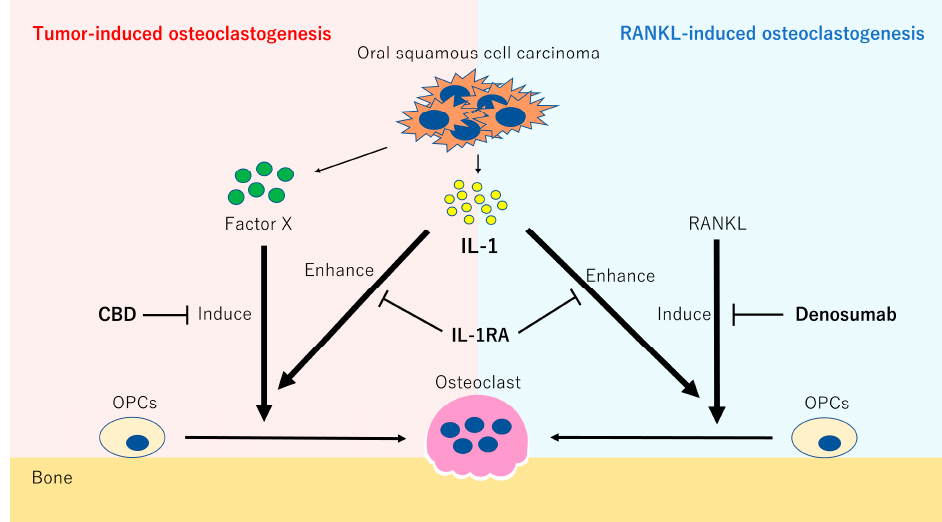
Figure 6. Hypothesis of the mechanism of bone resorption induced by the infiltration of